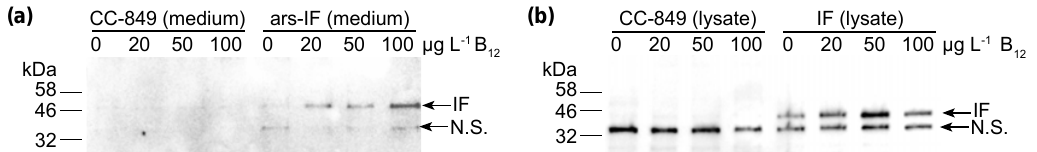
Figure 2. Expression of human intrinsic factor (IF) protein and ars ‐ IF in C. reinhardtii CC ‐ 849 detected by immunoblot analysis using HA ( α HA) and intrinsic factor ( α IF) antibodies, respectively, in the culture medium and cellular lysates. ( a ) Cellular lysates of IF strain expressing the protein. The protein band is indicated with an arrow (IF). A second, non ‐ specific band cross ‐ reacting with the HA antiserum is indicated (N.S.). ( b ) Culture supernatant (medium) of transformed CC ‐ 849 strain expressing ars ‐ IF. ‘C’ indicates a negative control (cellular lysate and supernatant of the untransformed CC ‐ 849 strain). ( c ) Cellular lysates of ars ‐ IF strain and CC ‐ 849. ( d ) Culture medium of ars ‐ IF and IF strain.